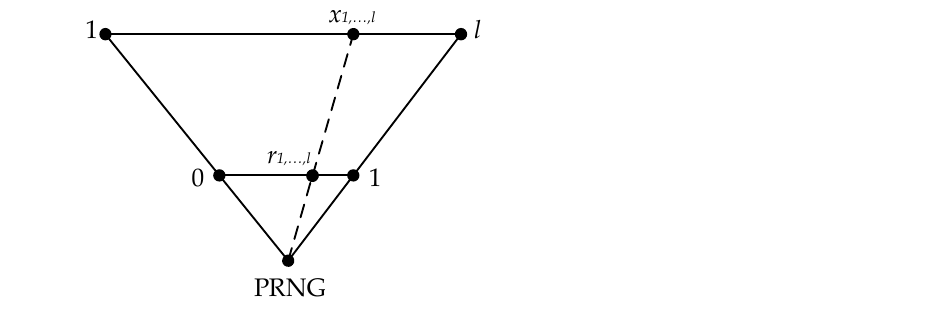
Figure 3. Scheme for converting pseudo-random numbers r 1,..., l from the range ( 0;1 ) into numbers x 1,..., l with the range ( 1; l )